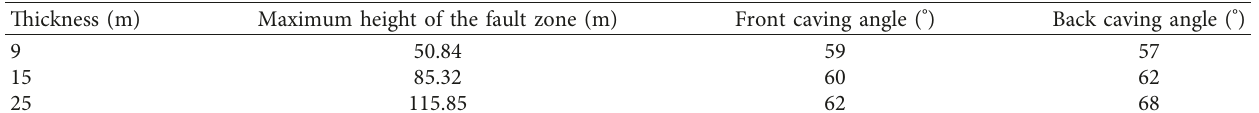
Figure 6: Some typical roof collapse of mining caving in coal with a thickness of 25m. (a) 144m; (b) 200m. Table 2: The movement of overlying strata with different mining thicknesses.